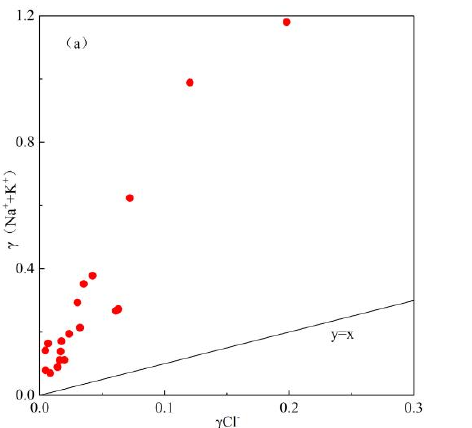
Figure 5. Relative contribution of weathering and dissolution of rocks.